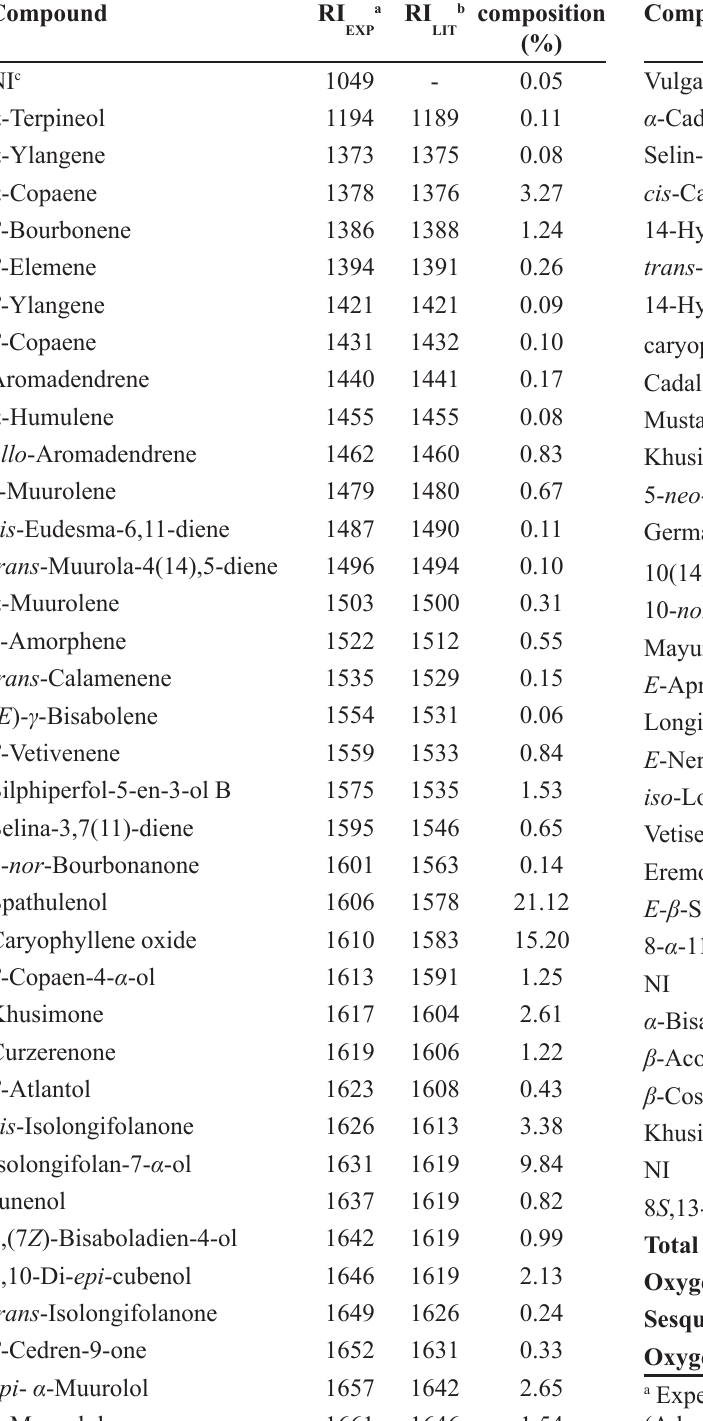
TABLE I - Composition of the essential oil from fresh leaves of M. plinioides